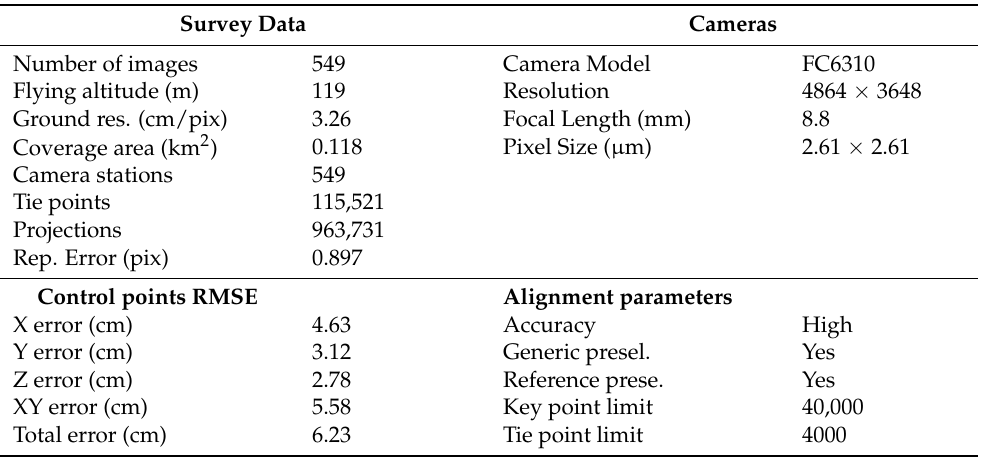
Table 1. Photogrammetric survey and camera data, errors of check points and alignment perimeters